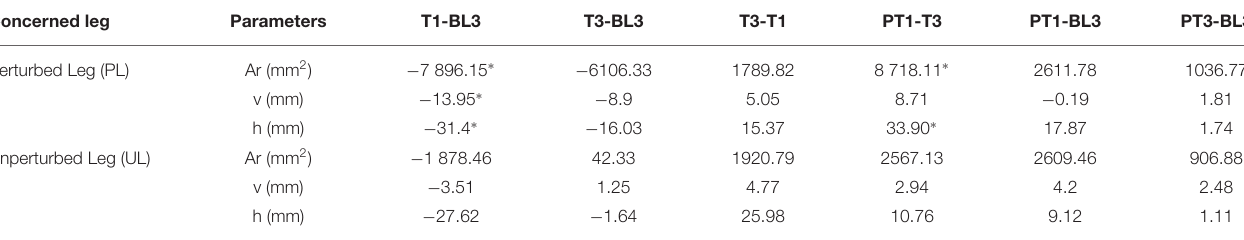
TABLE 1 | Ankle trajectory parameters for both legs, Perturbed Leg (PL) and Unperturbed Leg (UL), in Experiment I. Concerned leg